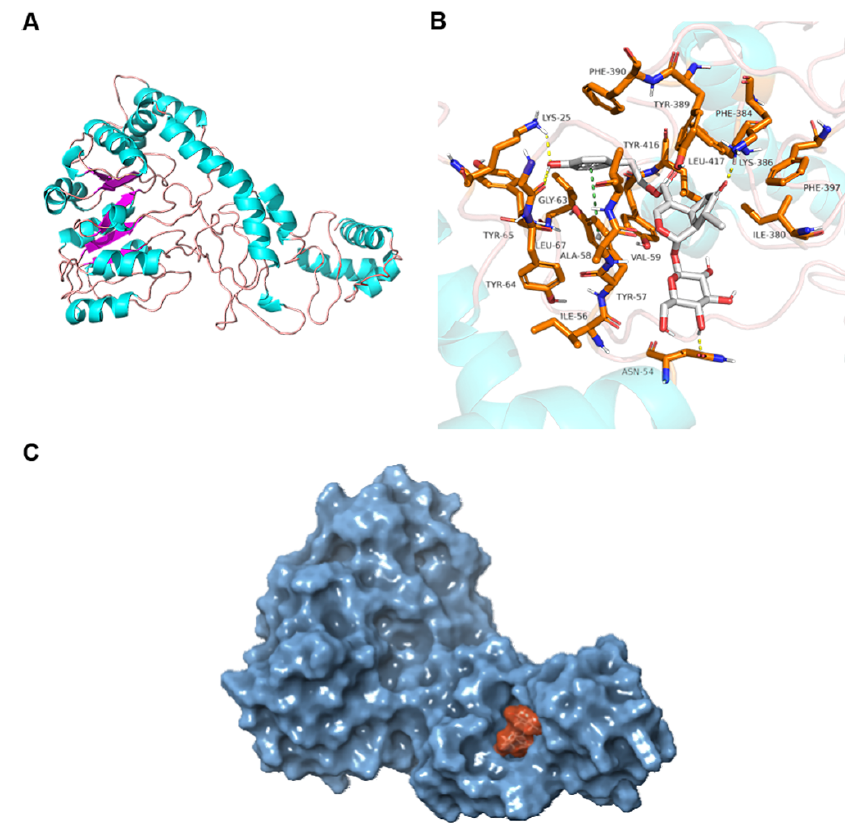
Figure 8. The structure of Orfy protein was shown in ( A ). The binding mode of syringopicroside combing with Orfy protein ( B ). The white sticks represent the ligand and the orange sticks represent residues. The yellow dotted line represent the hydrogen bond. The whole surface graphic of the ligand-protein complex ( C ). The orange part is syringopicroside and the blue part is Orfy protein.